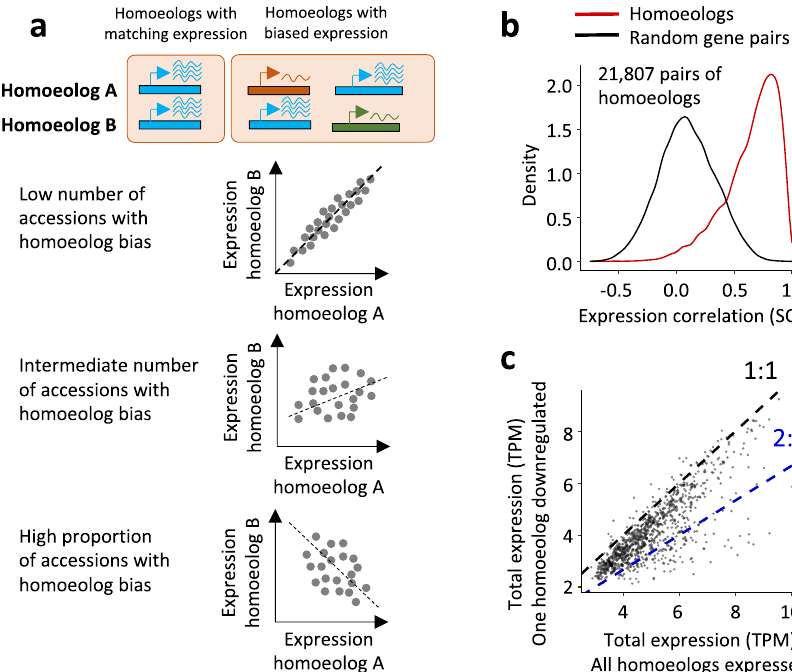
Fig. 1 Relative expression of homoeologous genes in the diverse panel of wheat lines. a Homoeologous gene pairs with matching and biased expression abundance of homoeolog A relative to homoeolog B. Red and green colors show low-expressing homoeologs in the A and B genomes, respectively. Increase in the frequency of accessions with a biased homoeolog is expected to reduce correlation between the levels of homoeolog expression measured in the panel. b Distribution of Spearman correlation coef fi cients (SCC) calculated between the AB, BD, AD gene pairs within the same homoeologous gene triplets (red) and random (black) pairs of genes using gene expression values from the 198 accessions. c The mean of the sum of the total triplet expression (A + B + D) in groups of accessions with ( y -axis) and without ( x -axis) one of the gene copies downregulated. The red and blue dotted lines show the 1:1 and 2:3 combined expression ratios, respectively. Source data are provided as a Source Data fi